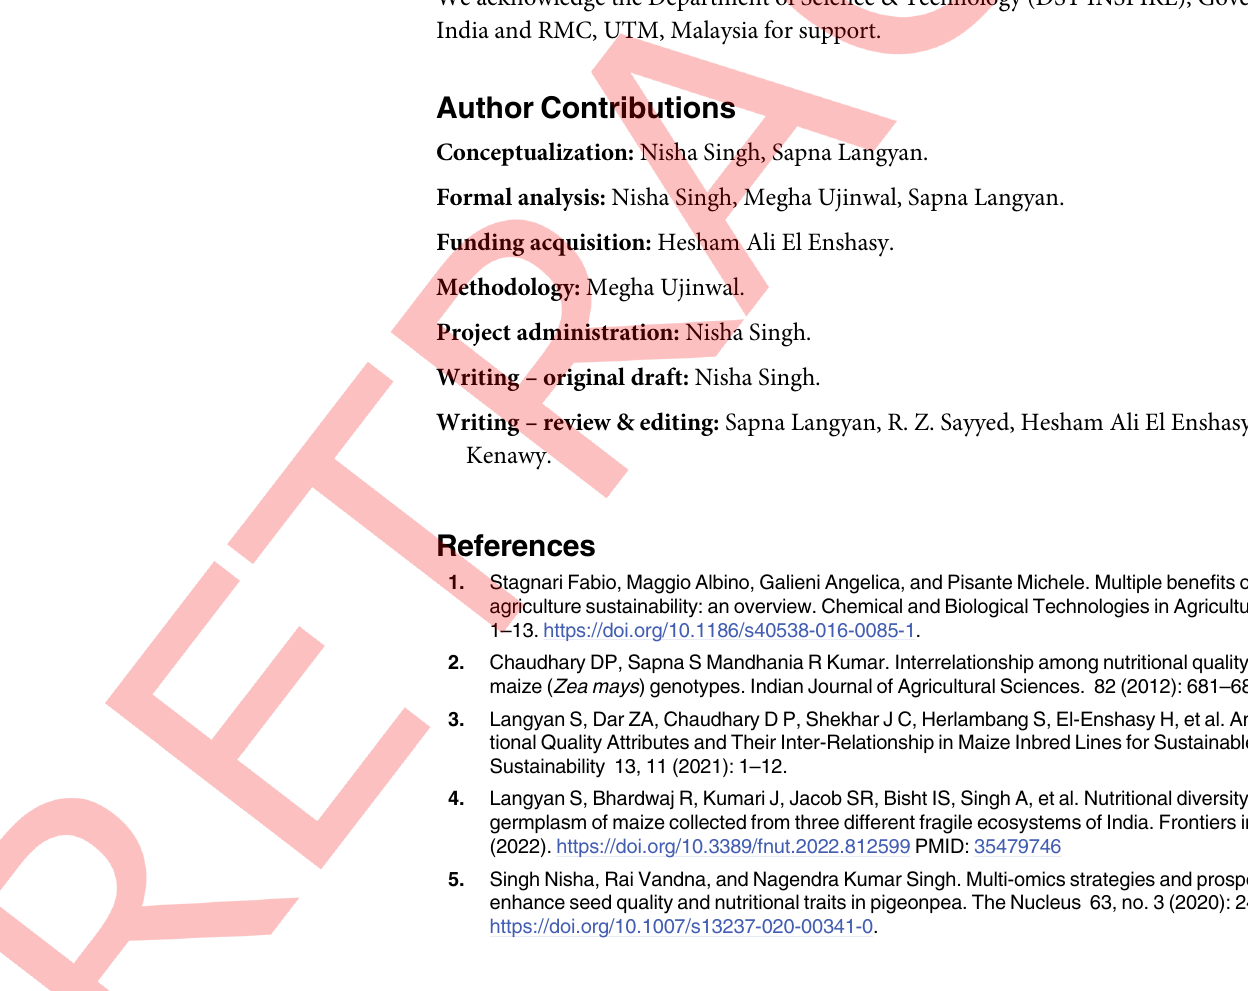
S1 Fig. 3-Dimension structure of 155 SWEET proteins present in 12 Fabaceae. S1 Table. Physiochemical properties of the amino acid encoding in SWEET